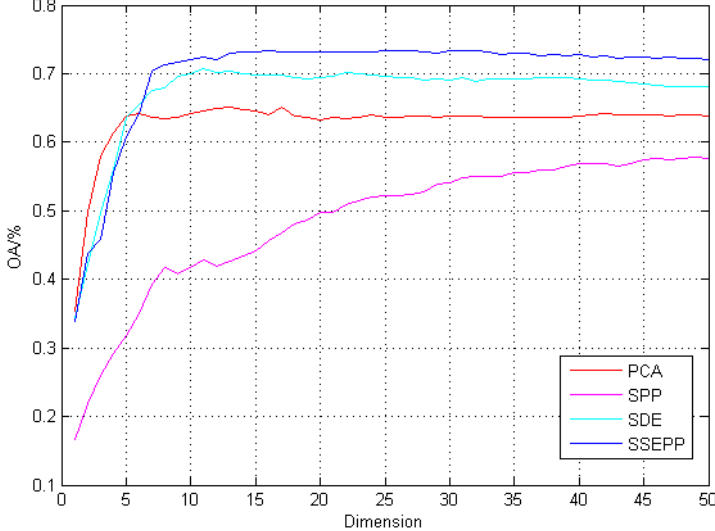
Figure 2. Overall accuracy curves of different DR algorithms in different dimensions. Table 3. Classification of land cover